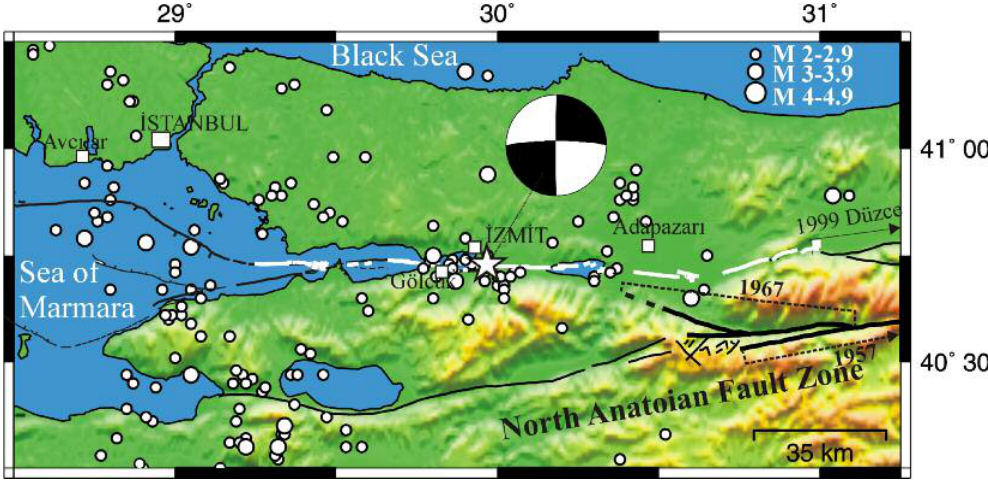
Figure 13. Seismicity of the August 17, 1999, İ zmit earthquake source region during the year before the earthquake. The seismicity data were recovered from the catalog of Kandilli Observatory and the Earthquake Research Institute. The mapped surface ruptures (thick white lines) and the focal mechanism of the earthquake are also shown. White star, epicentre. The onshore fault extents are drawn from Ş aro ğ lu et al. [1992], while the offshore extents are drawn from Armijo et al.